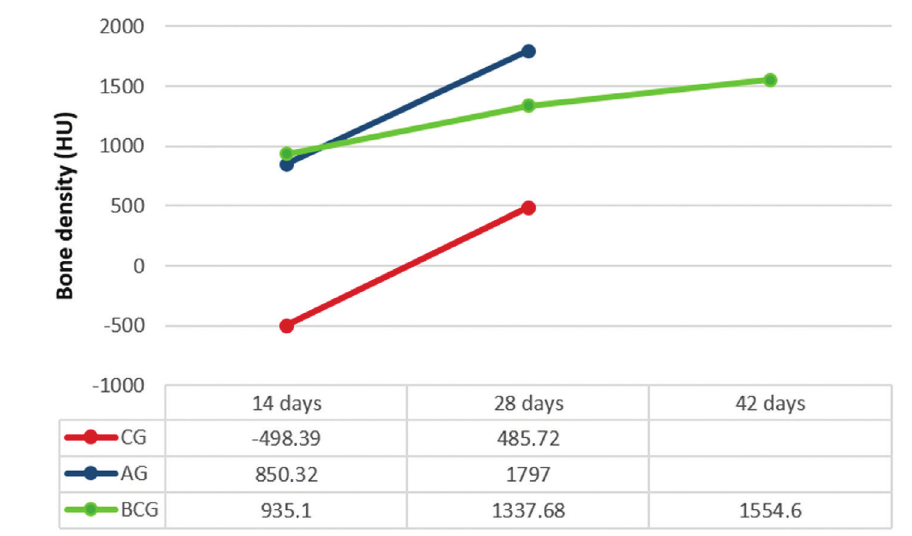
Figure 10- BMD average data obtained by μCT of CG, AG, and BCG (14, 28 and 42